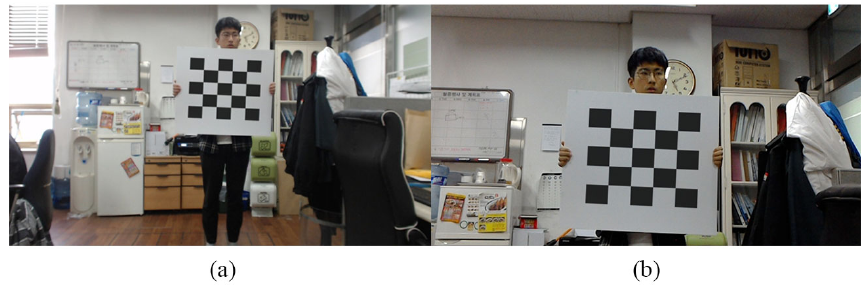
Figure 4. Camera calibration process for extracting RGB camera internal parameters and acquiring distance difference between RGB camera and HoloLens camera. ( a ) RGB camera picture; ( b ) HoloLens camera